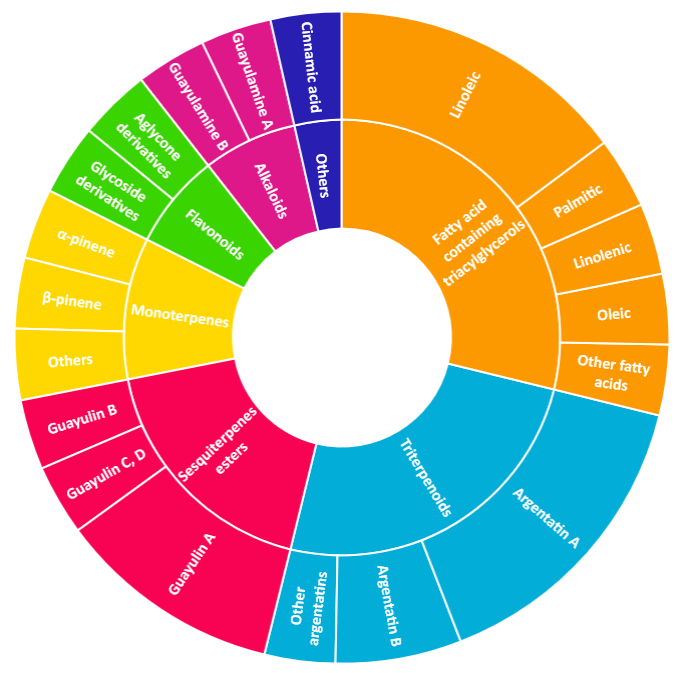
Figure 8. Composition of guayule resin from compiled literature data. Table 2. Summary of the extraction